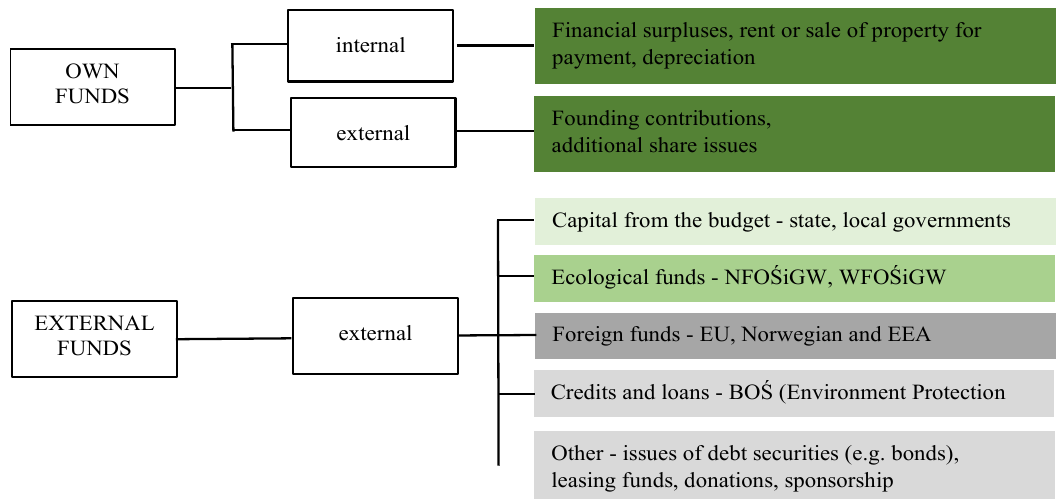
Figure 1. Sources of financing for pro-ecological projects in Poland, available depending on the entity, including its organizational and legal form. Source: Designed by authors using [66,67].